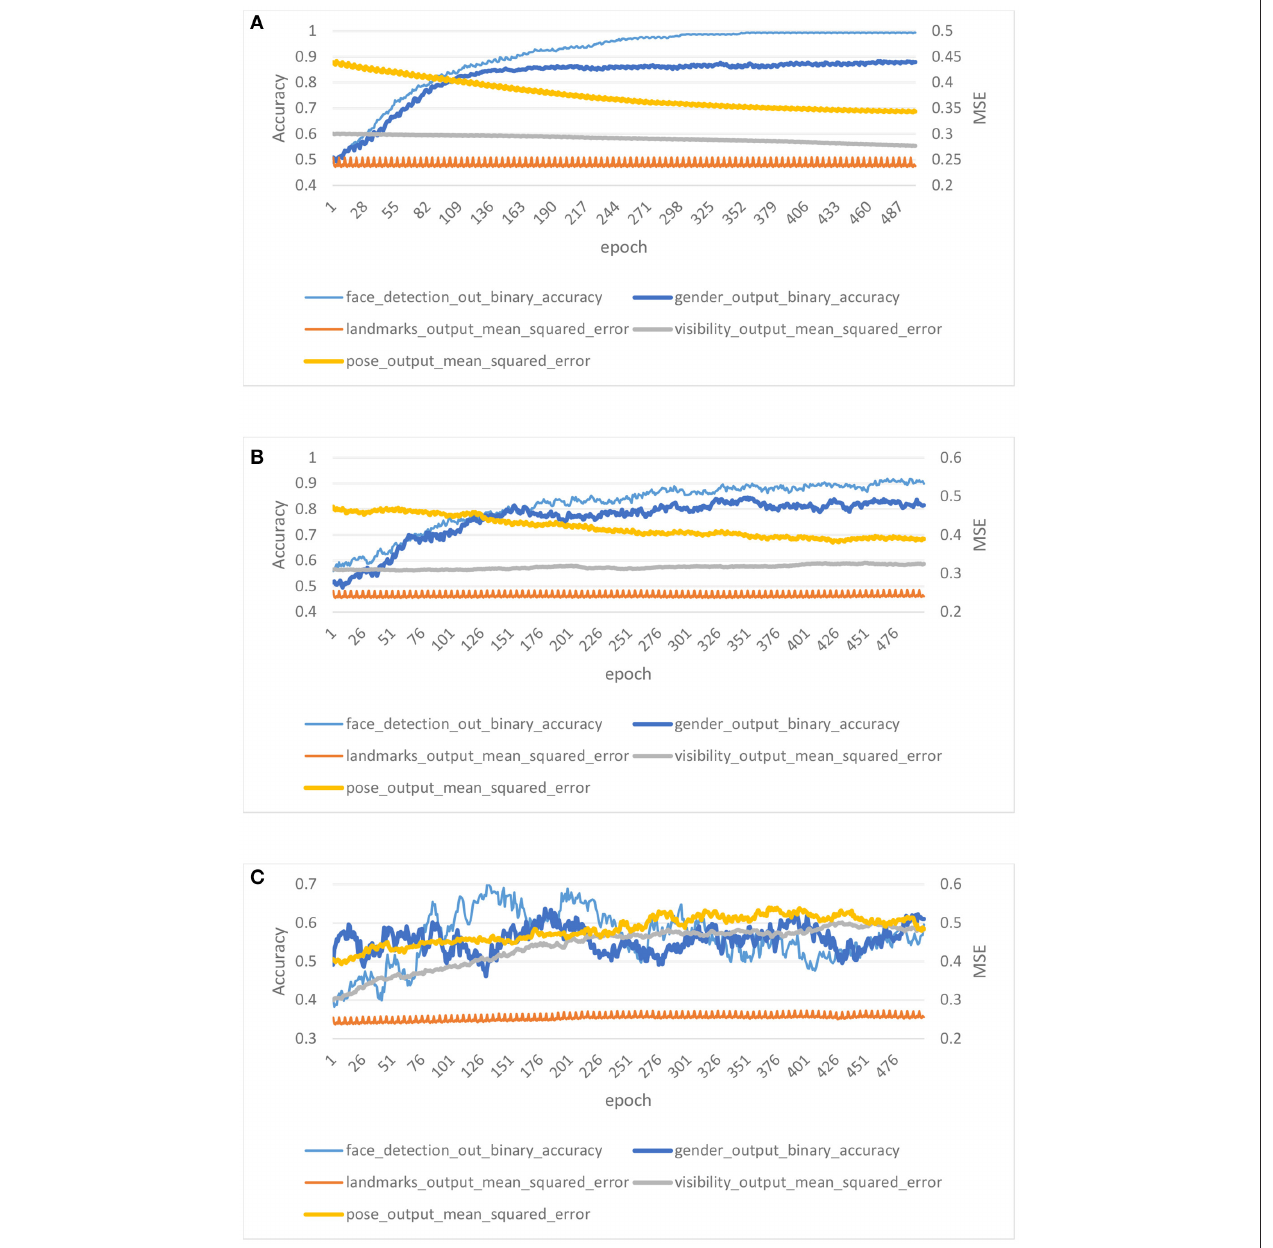
points of negative candidate regions are set to invisible by